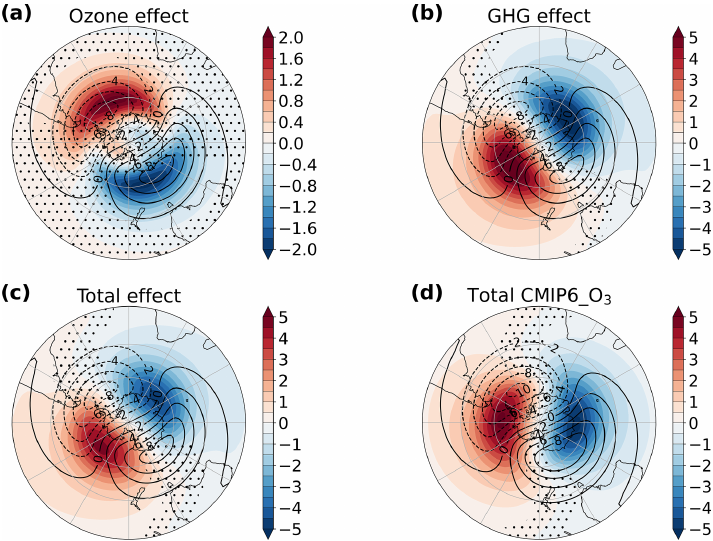
Figure 7. Changes in the temperature PW1 (K) at 50hPa during October (color shading): effect of ozone recovery (a) , effect of GHGs (b) , total effect in INTERACT_O 3 (c) , and total effect in CMIP6_O 3 (d) . The contours depict the current-day (2011–2030) PW1 climatology from INTERACT_O 3 in (a) – (c) and from CMIP6_O 3 in (d) . The stippling masks regions where the changes are not significant at the 95% confidence interval based on a two-tailed t test.